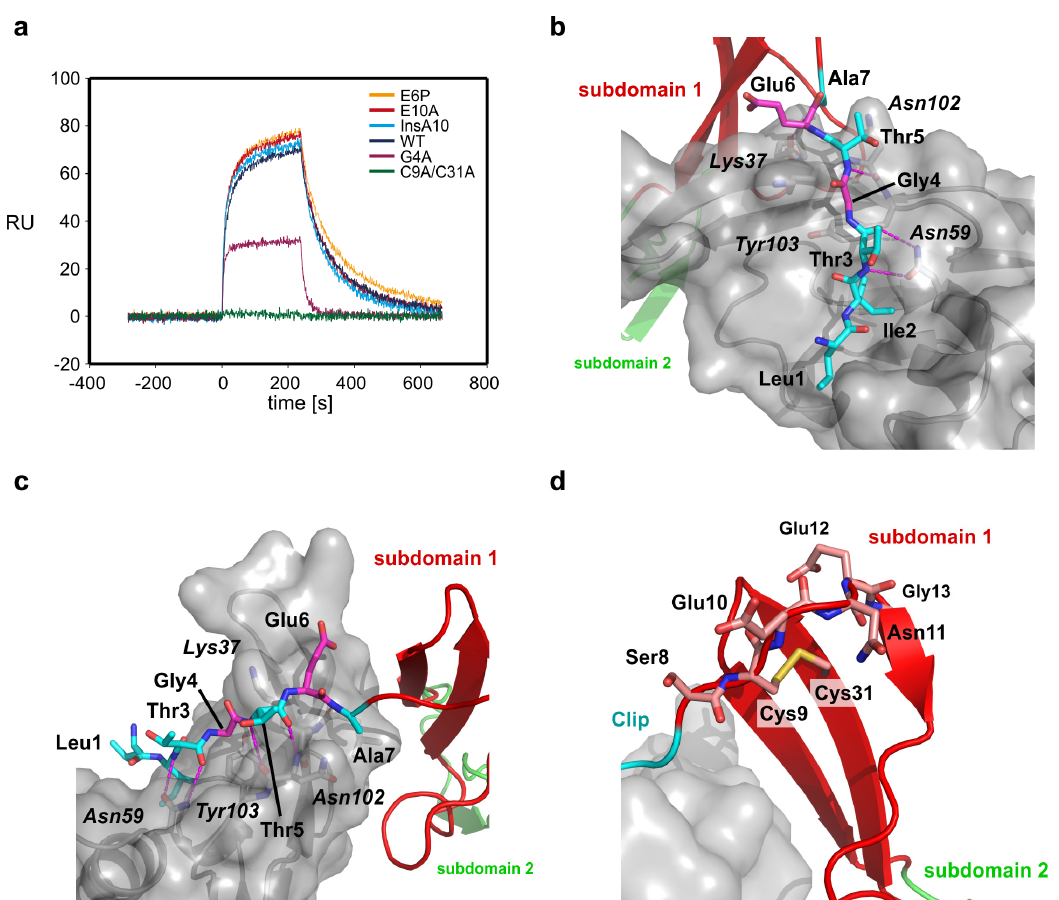
Figure 3. ( a ) Sensorgram of the interaction of CV2 VWC1 and mutants thereof. For comparison the perfusion of CV2 VWC1 proteins with an analyte concentration of 75 nM is shown. Perfusion of the analyte starts at time point 0, after 240 s analyte perfusion is stopped and dissociation data is observed from perfusion of the biosensor with buffer. Whereas the mutants E6P, E10A and the CV2 VWC1 mutant harboring an alanine insertion at position 10 display wildtype like binding kinetics, mutants G4A and the disulfide bond deletion mutant C9A/C31A show a dramatic loss of binding and an altered binding kinetics. ( b ) Details of the interaction between the residues of the CV2 VWC1 Clip segment and the binding site of BMP-2. Intermolecular hydrogen bonds are shown as stippled lines. The effect of mutating Leu1, Ile2, Thr3 and Thr5 (marked with cyan carbon atoms) has been investigated before, mutating Gly4 and Glu6 (carbon atoms colored in magenta) has different effect on BMP-2 binding. Whereas mutation E6P does not alter BMP-2 affinity, exchange of Gly4 by alanine dramatically lowers BMP-2 binding affinity likely due to introducing steric hindrance between the side chain at position 4 of the Clip and residues, e.g., Tyr103 at the BMP-2 surface. ( c ) As in ( b ) but seen from a different orientation. ( d ) The disulfide bind between Cys9 and Cys31 fixes the orientation of the Clip segment by anchoring the Clip segment onto the β -sheet of subdomain 1 and introducing a hook-like structure between residues Glu10 to Gly13. Introducing a single additional residue (mutant InsA10) at the C-terminal site of Cys9 seems not alter the hook-like structure enough to disrupt BMP-2